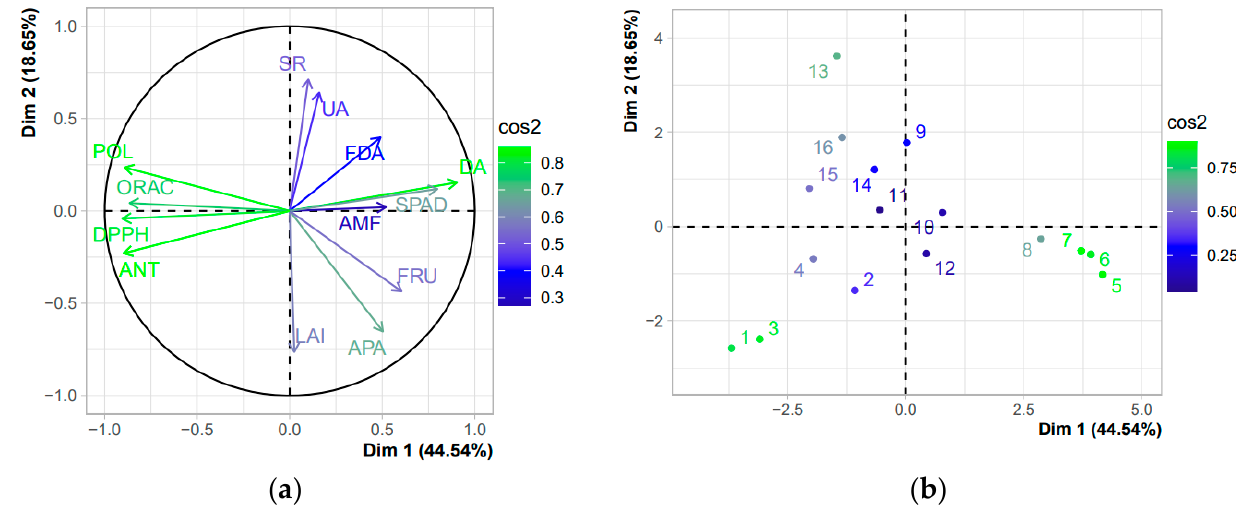
Figure 8. Principal component analysis (PCA) of arbuscular mycorrhizal fungi (AMF); soil microbiological activity (FDA); soil microbial respiration (SR); urease activity (UA); dehydrogenase activity (DA); acid phosphatase activity (APA); leaf area index (LAI); chlorophyll index (SPAD); fruit yield (FRU); total polyphenols (POL); DPPH antioxidant capacity (DPPH); ORAC antioxidant capacity (ORAC); and total anthocyanins (ANT). ( a ) PCA of variables; ( b ) PCA of individuals.